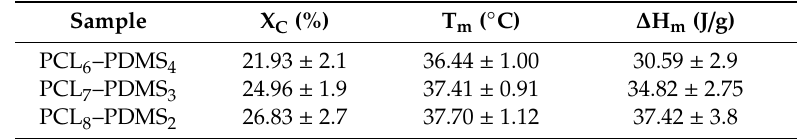
Table 2. The thermal properties of the PCL–PDMS copolymer samples measured by DSC.